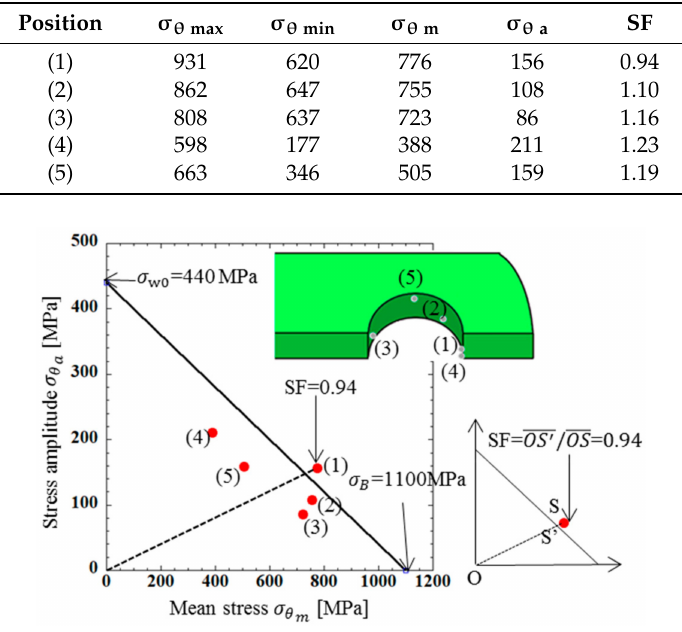
Figure 9. Fatigue limit diagram for inner plate